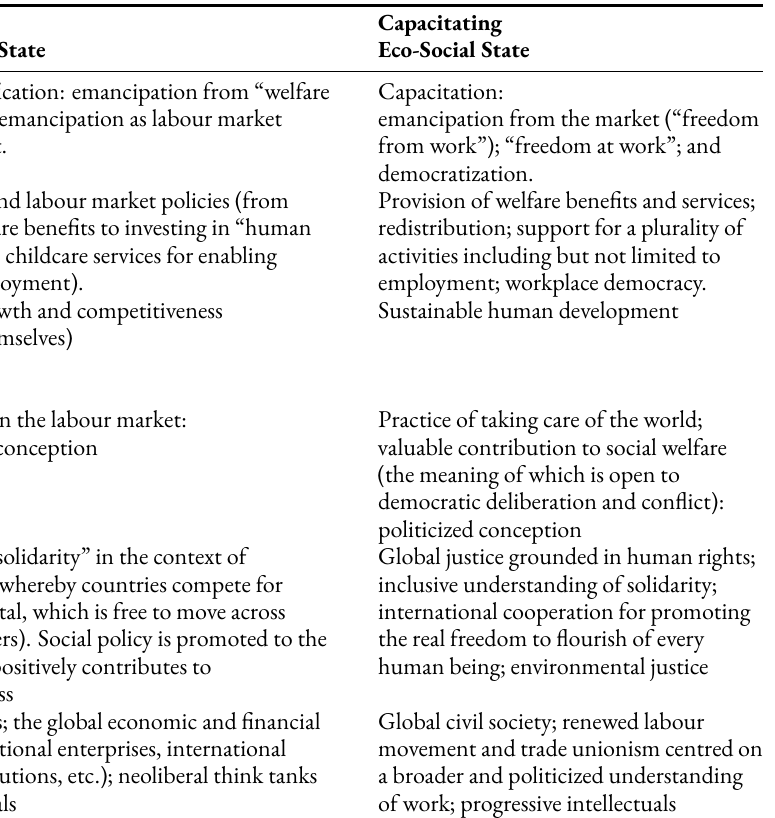
Table 1: Summary of the vision for a capability-oriented eco-social state and of the main differences with respect to the post-war welfare state and neoliberal competition